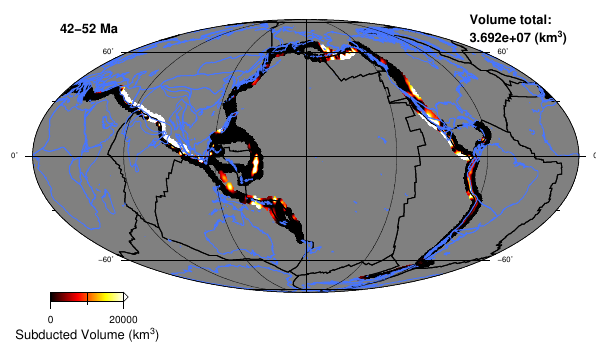
Figure B1. Integrated volume of subducted material between 52 and 42Ma. The colour scale represents the volume of material. The total amount of material for this time period is 3 . 7 × 10 7 km 3 .